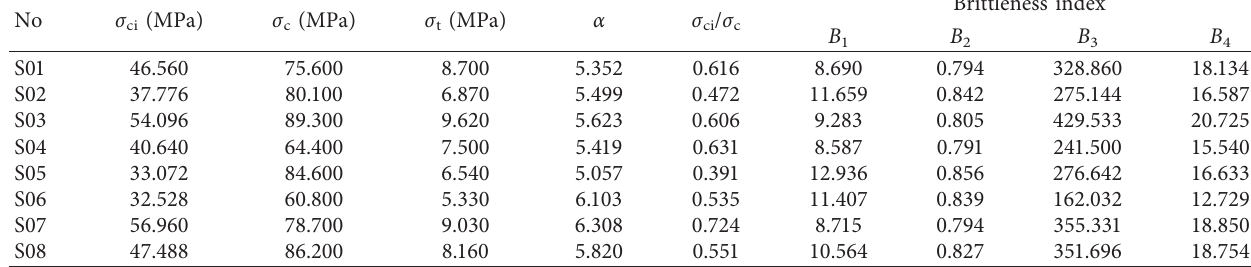
Table 3: Summary of mechanical parameters of limestone samples.